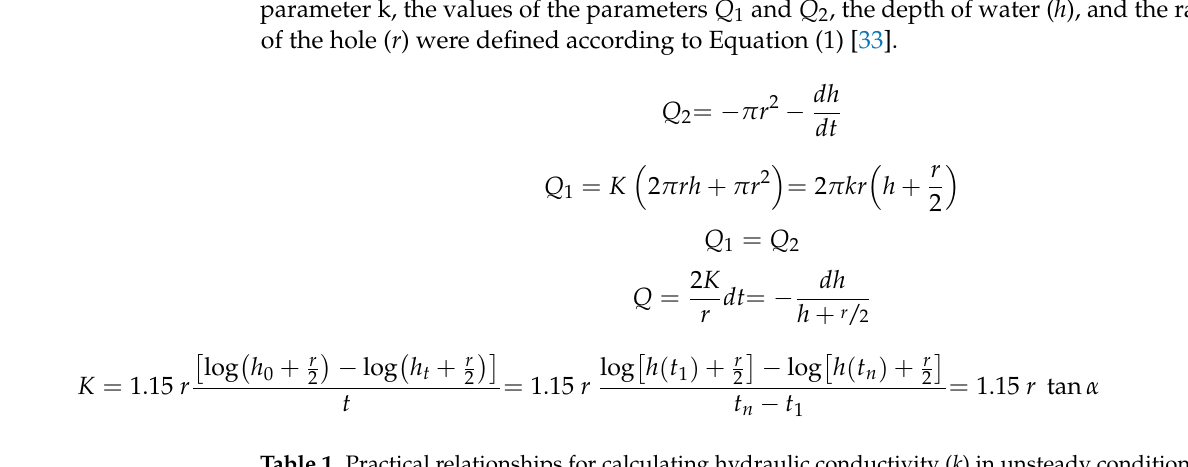
Table 1. Practical relationships for calculating hydraulic conductivity ( k ) in unsteady conditions and inverse auger hole laboratory model [33].